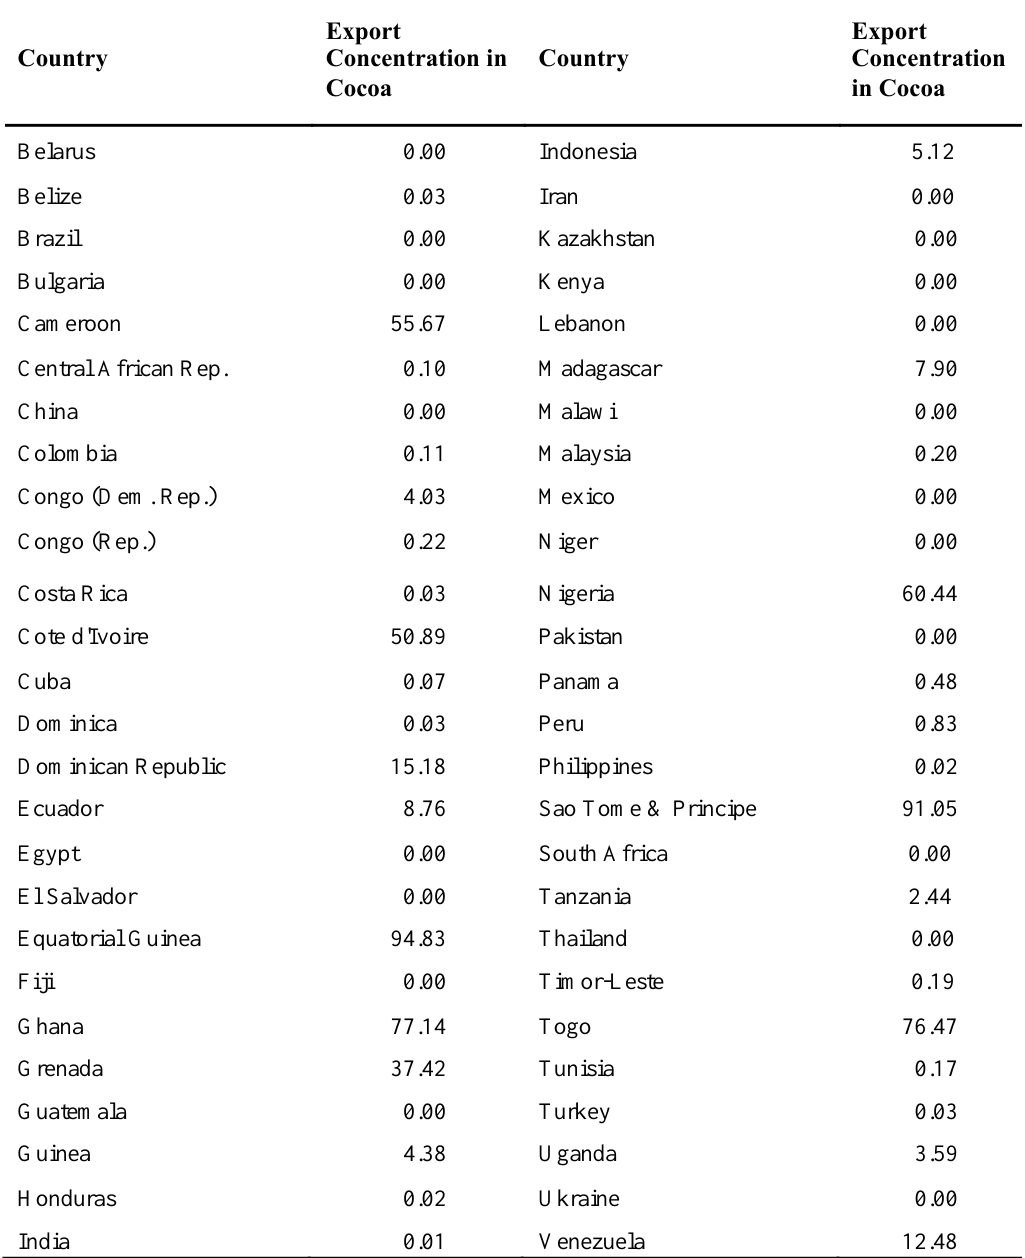
Table 4. Countries in the 2014